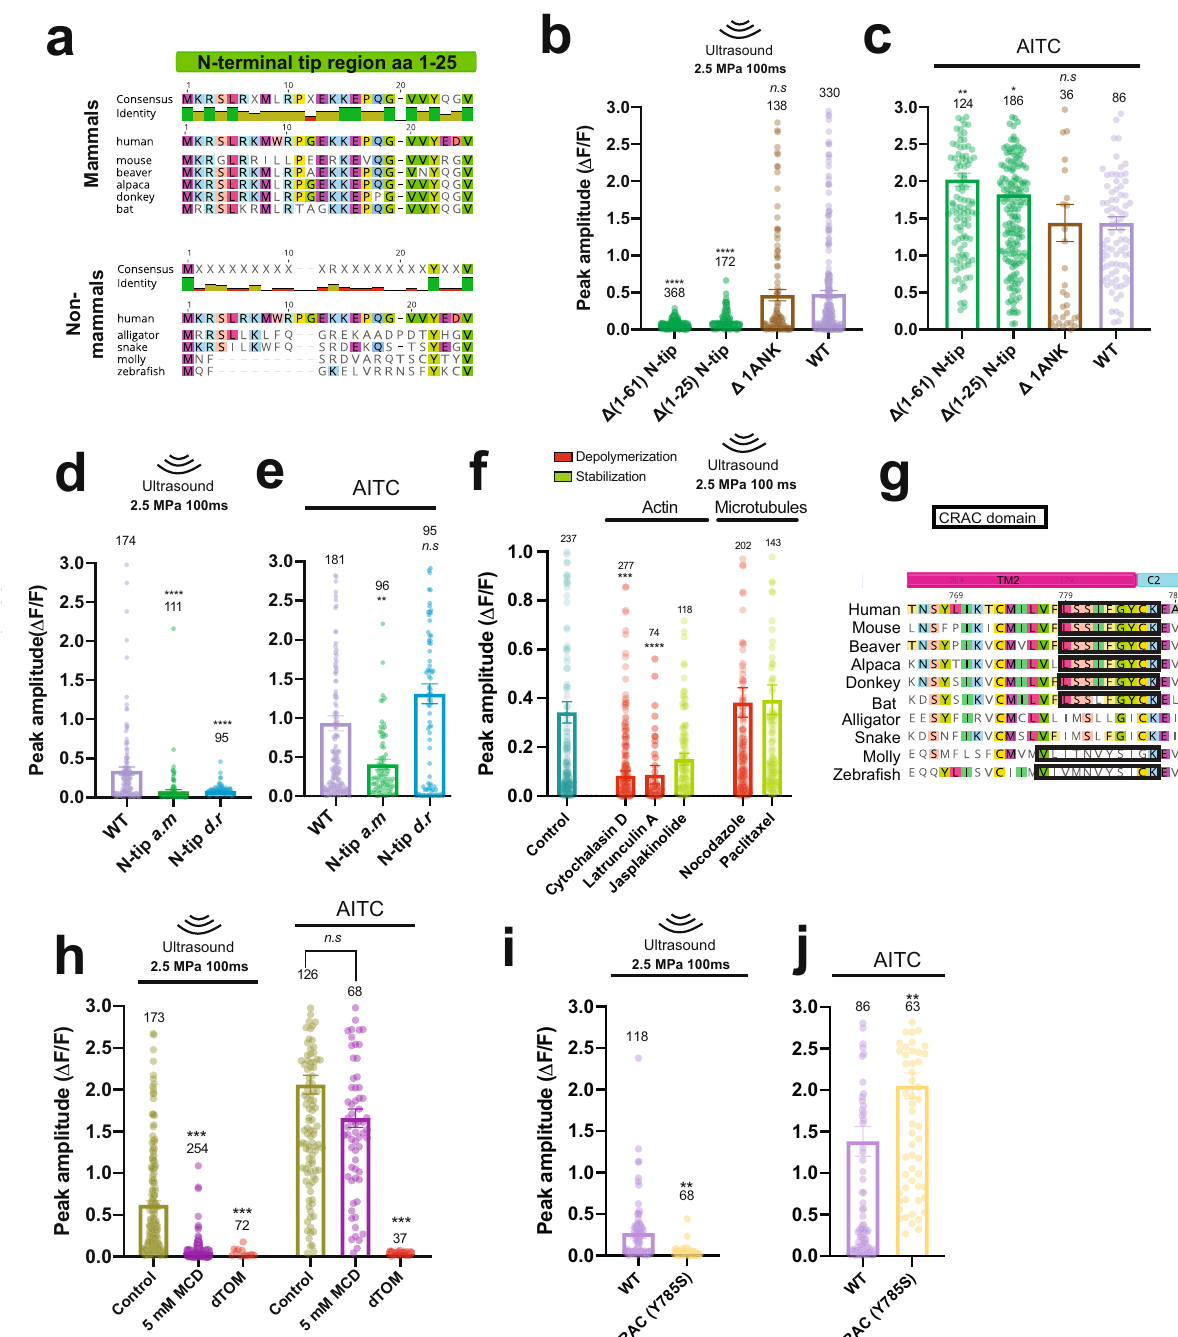
Fig. 3 The N-terminal region of hsTRPA1, actin cytoskeleton, and cholesterol contribute to ultrasound sensitivity. a Mammalian and non-mammalian alignments of the TRPA1 N-terminal tip region (aa1-25) from homologs tested for ultrasound sensitivity. GCaMP6f peak amplitude upon b , ultrasound stimulation or c , treatment with AITC (33 μ M) in HEK cells transfected with either full-length hs TRPA1 or channels containing deletions of the whole N-terminal tip ( Δ (1 – 61)), an initial subsection of the N-tip ( Δ (1 – 25)) or only ankyrin repeat 1 ( Δ ANK1) without altering the pore or transmembrane regions. GCaMP6f peak amplitude upon d , ultrasound stimulation or e , treatment with AITC (33 μ M) in HEK cells transfected with either full-length hs TRPA1 or chimeras in which the N-tip from alligator TRPA1 (N-tip a.m) or from zebra fi sh (N-tip d.r) was swapped in. f GCaMP6f peak amplitude following ultrasound stimulation in cells expressing hs TRPA1 after treatment with agents that either stabilize (green) or destabilize (red) microtubules and actin fi laments compared to vehicle control. g Transmembrane 2 domain sequence alignment across species tested for ultrasound sensitivity with Cholesterol Recognition/interaction Amino acid Consensus (CRAC) domain outlined. h GCaMP6f peak amplitude in hs TRPA1-expressing HEK cells upon ultrasound stimulation or AITC treatment (33 μ M) after incubation with MCD (5 mM) or control. i GCaMP6f peak amplitude in HEK cells expressing either WT hs TRPA1 or a mutant with TM2 CRAC domain disrupted (Y785S) upon ultrasound stimulation or j AITC treatment (33 μ M); Data are mean ±